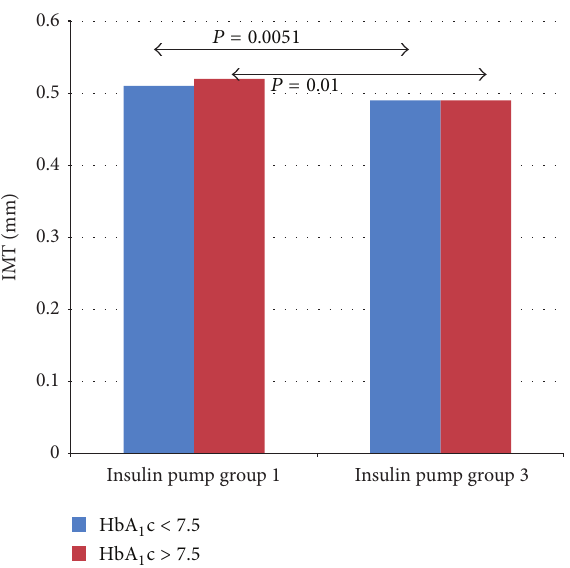
Figure 4: A change in HbA 1 c in the groups depending on the initial value < 7.5% and > 7.5% (1—before CSII, 2—after 3 months of CSII, and 3—after 6 months of CSII).